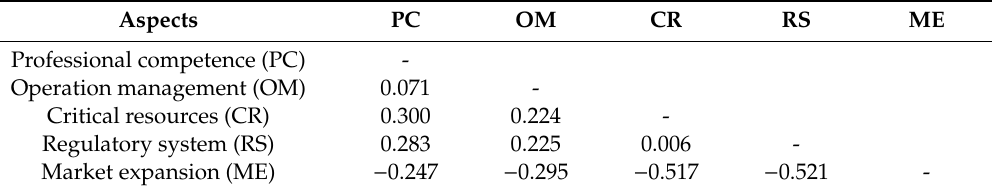
Table 10. The net influence matrix.